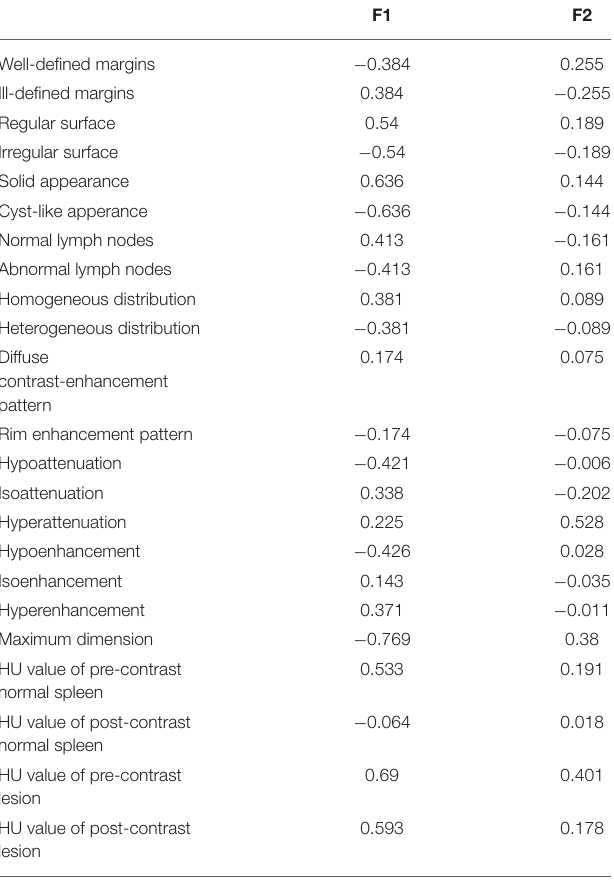
TABLE 3 | F1 and F2 values of the factorial discriminant analysis based on 8 qualitative and 5 quantitative